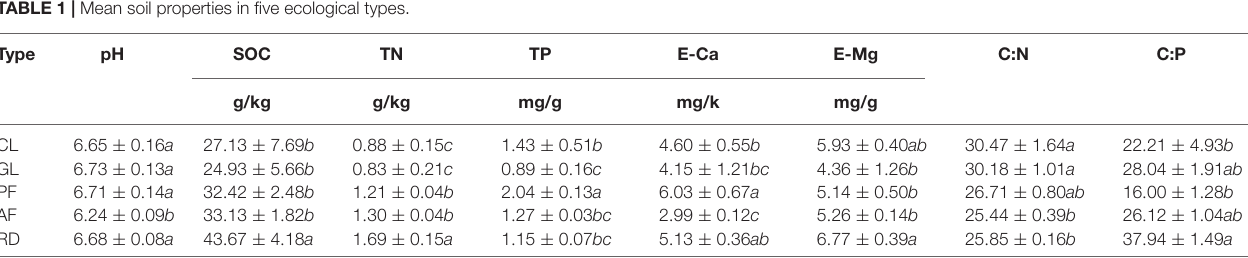
FIGURE 1 | Map showing localization of the bulk soil samples in Hani-Yi Autonomous Prefecture of Honghe, China. Figure 1 was generated by QGIS that is a free and open source geographic information system (https://www.qgis.org/en/site/). TABLE 1 | Mean soil properties in five ecological